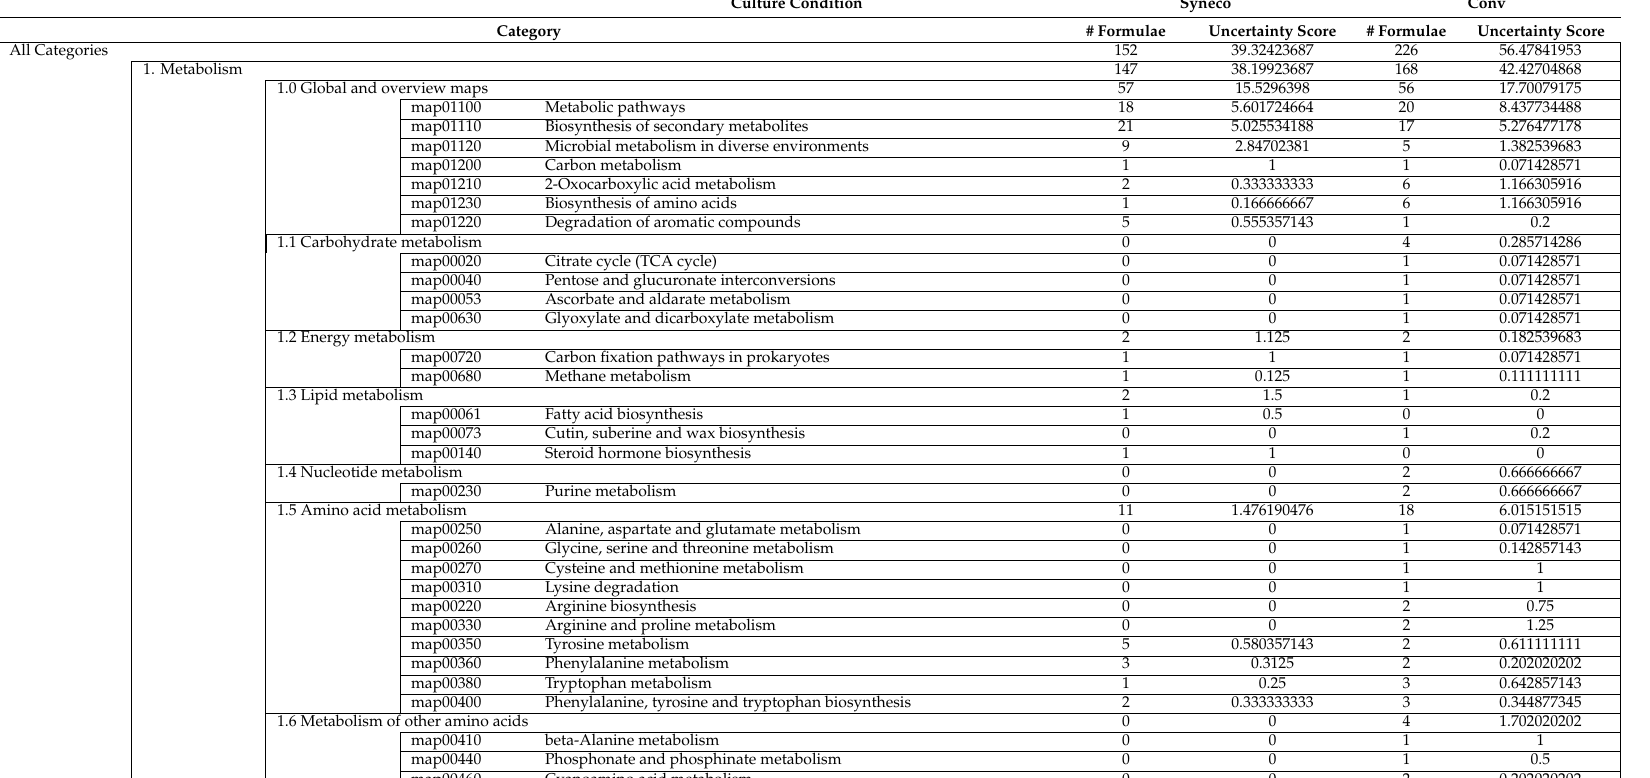
Table 3. KEGG PATHWAY compound classification. The numbers of di ff erent chemical formulae (# Formulae) associated with the Syneco- and Conv-distinctive loadings for each category of chemical ontology in KEGG PATHWAY hierarchy were shown. The pathway related to microbial metabolism is typed in red. See the Supplementary Materials Files S6, S7, S9 and S10 for more